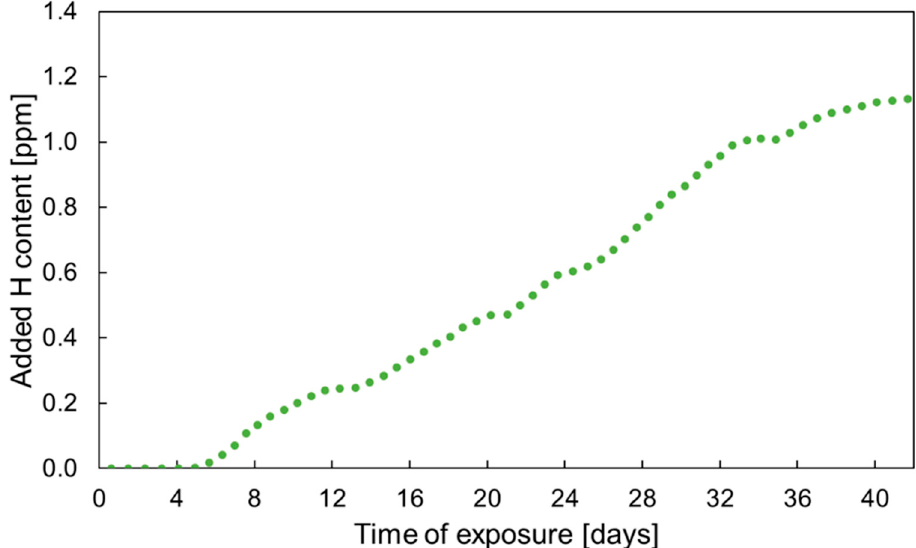
Figure 3. HERS measurement of added diffusible hydrogen content in DP1000 AHSS with NaCl deposits in humid air at 85% RH.